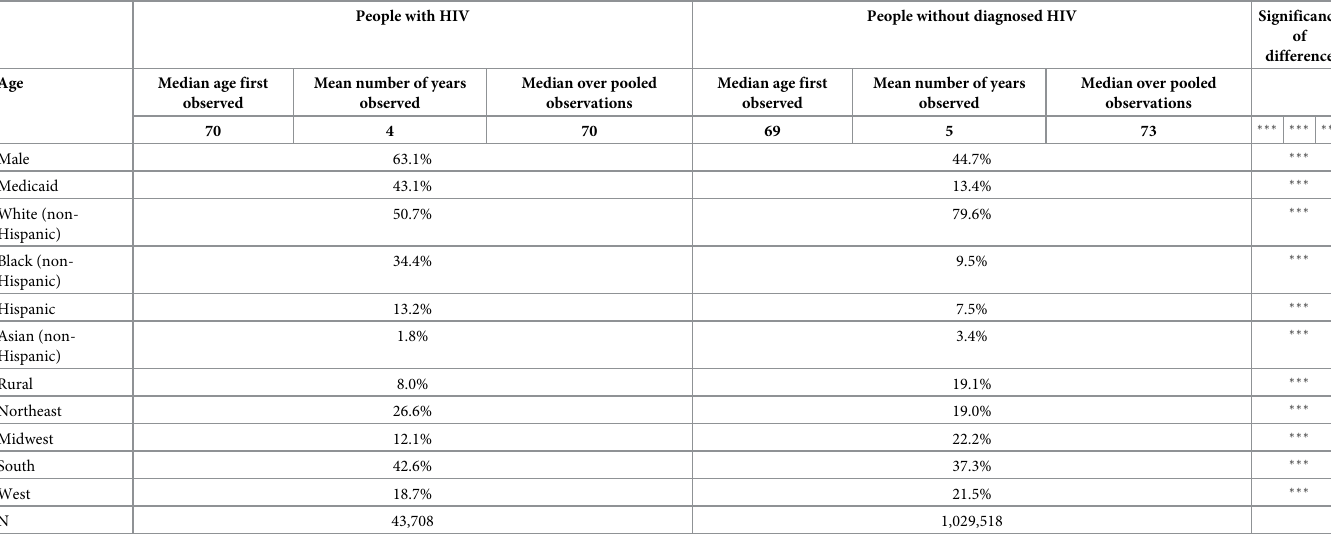
Table 1. Demographic and geographic characteristics, (Medicare beneficiaries aged 65 and over between 2011–2016).